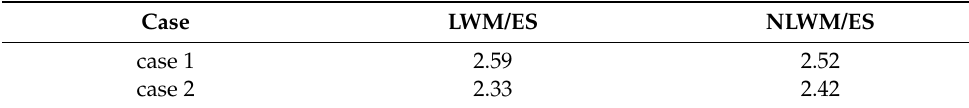
Table 2. Signal amplitude ratio of the maximum